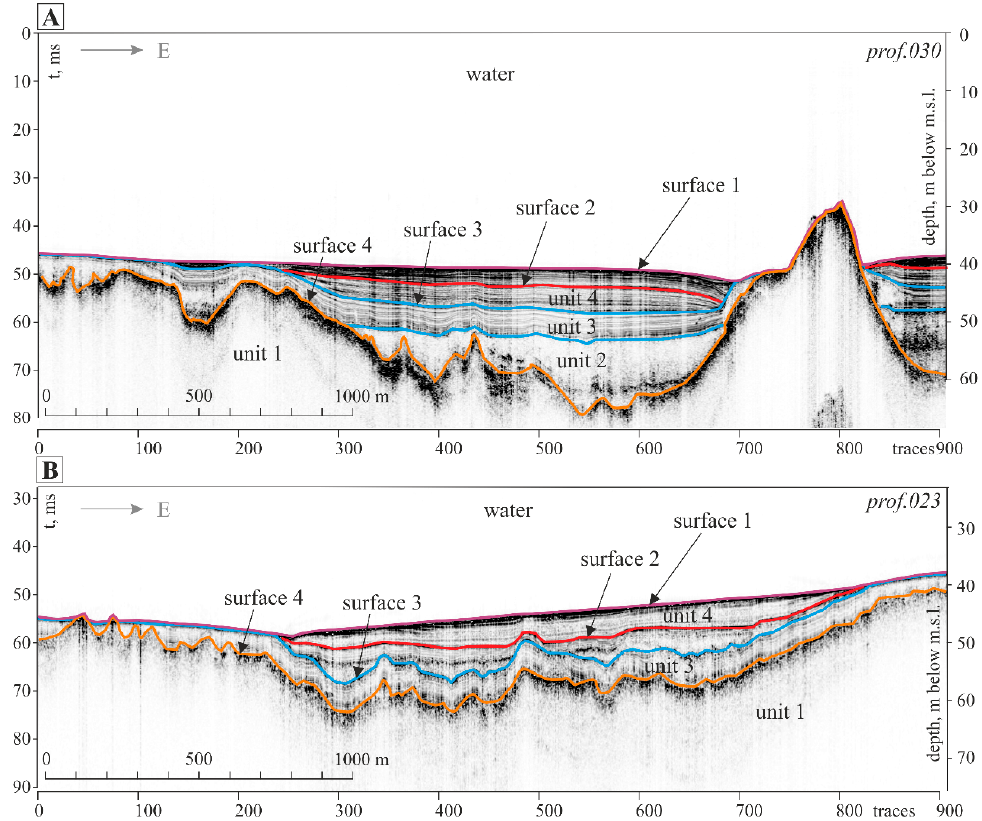
Figure 8. Seismic-reflection profiles: ( A ) Moschny Island key area (profile 023); ( B ) Vyborg Bay key area (profile 030). Interpreted acoustic units consist of Unit 1 = till (moraine); Unit 2 = questionably glaciofluvial sandy deposit; Unit 3 = Late Pleistocene glacio-lacustrine clays; Unit 4 = Holocene lacustrine and marine silty-clayey muds. Surface 1 = sea bottom surface; Surface 2 = inner erosion surface of Holocene mud; Surface 3 = top of Late Pleistocene clays; Surface 4 = top of till.